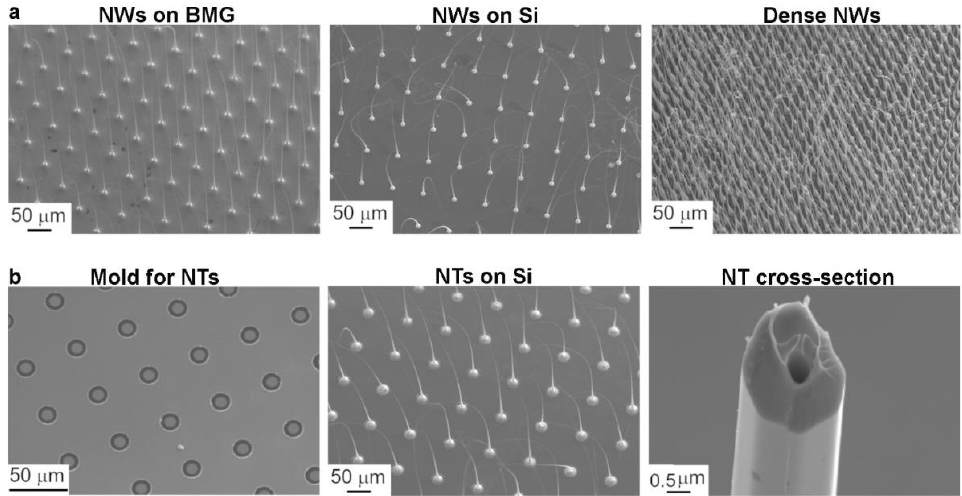
Figure 6. Thermoplastically drawn Pt-BMG nanowires (NWs) and nanotubes (NTs). ( a ) BMG NWs on the BMG and Si substrates. ( b ) The Si mold used for drawing of NTs and the drawn BMG NTs with hollow cross-section.